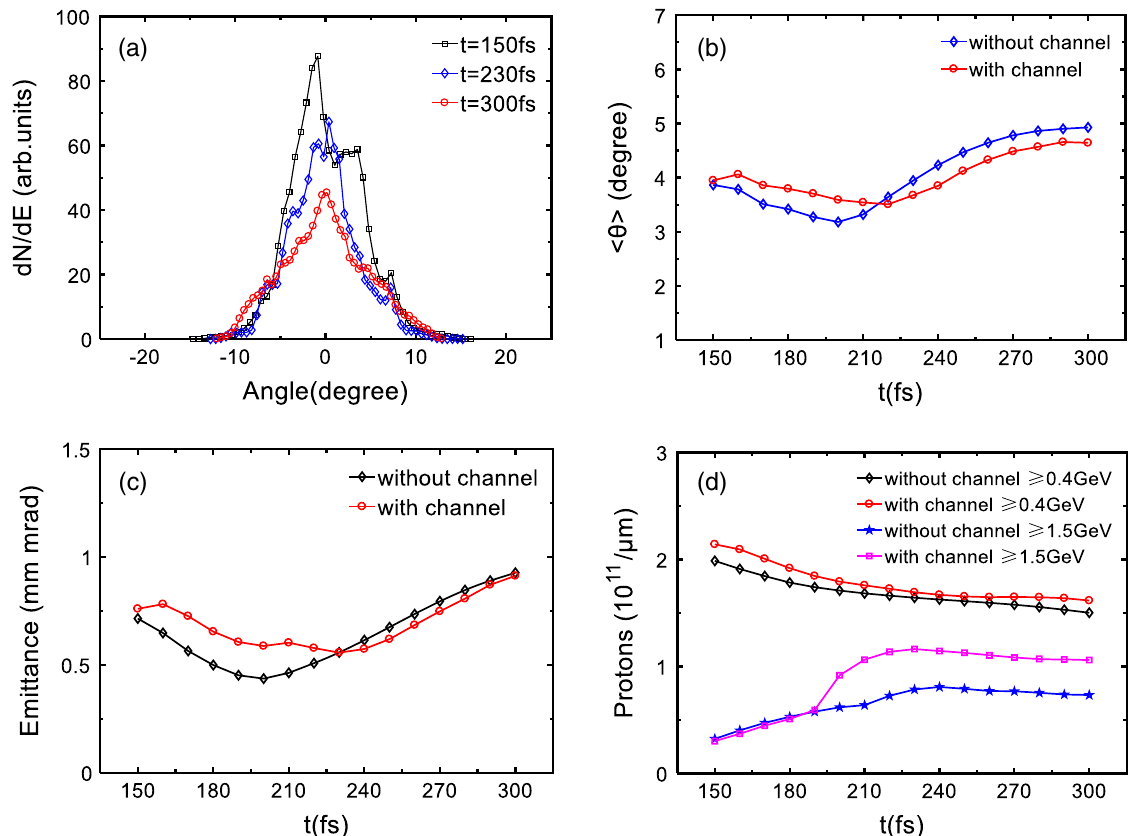
FIG. 7. (a) Angular spectrum of protons in the case with a channel at three moments: t ¼ 150 fs, t ¼ 230 fs, and t ¼ 300 fs. Temporal evolution of average divergence angle (b) and transverse emittance (c) for the protons in both cases, respectively. (d) Number of protons for different energies (i.e., ≥ 0 . 4 GeV and ≥ 1 . 5 GeV) in two cases. Here, we choose the protons in the region of − 6 λ ≤ y ≤ 6 λ